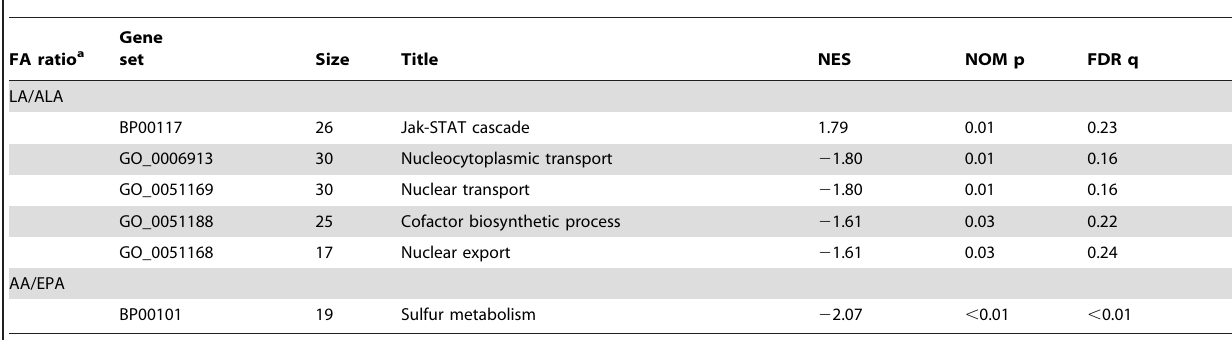
Table 8. Gene Set Enrichment